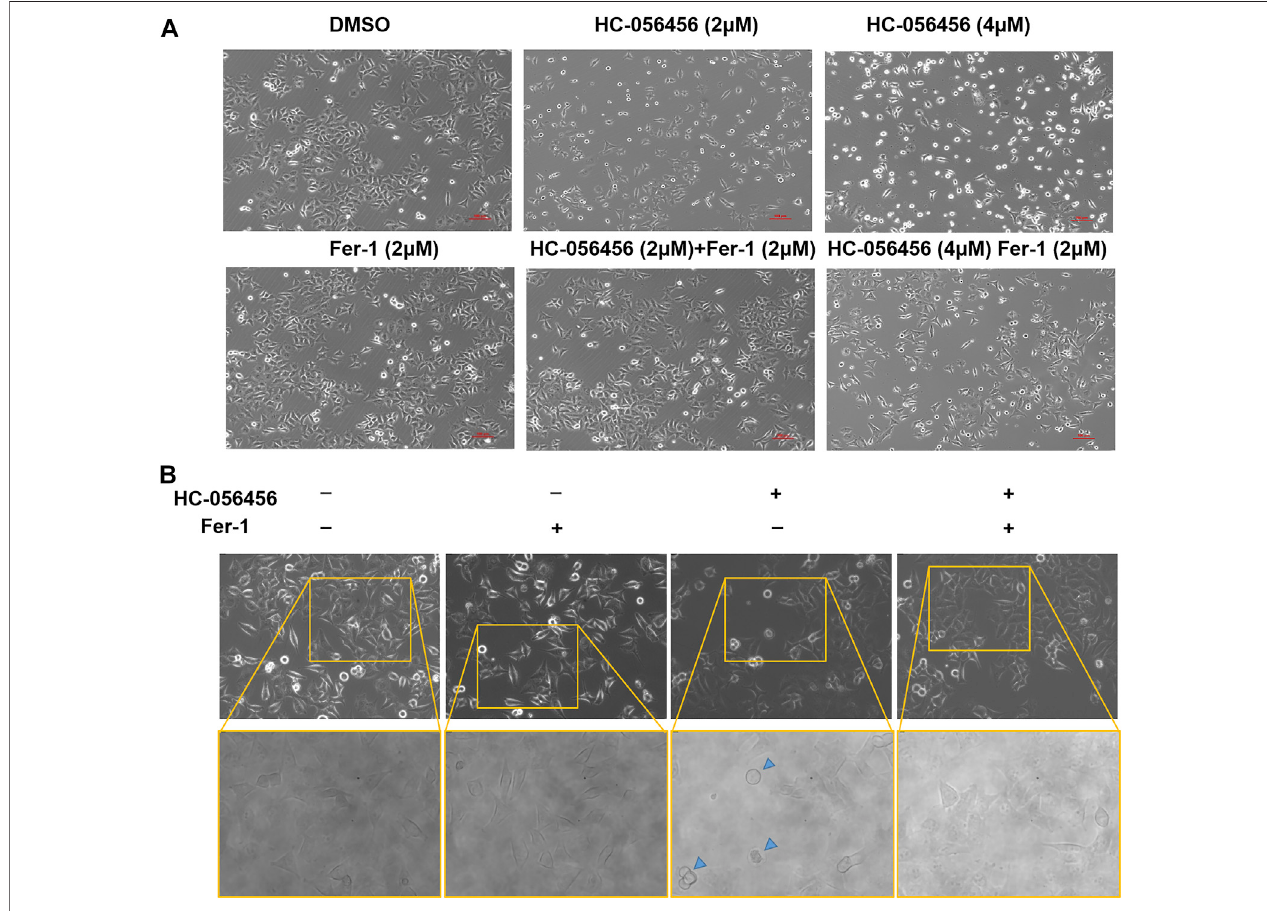
FIGURE 3 | Morphological Changes of MGC-803 (A) Optical microscopy images of MGC-803 cells treated with HC-056456 with or without Fer-1 for 24 h (magni fi cation, 10x) (B) The “ ballooning ” phenotype was recorded after HC-056456 treatment for 12 h (magni fi cation, 20x and 40x).